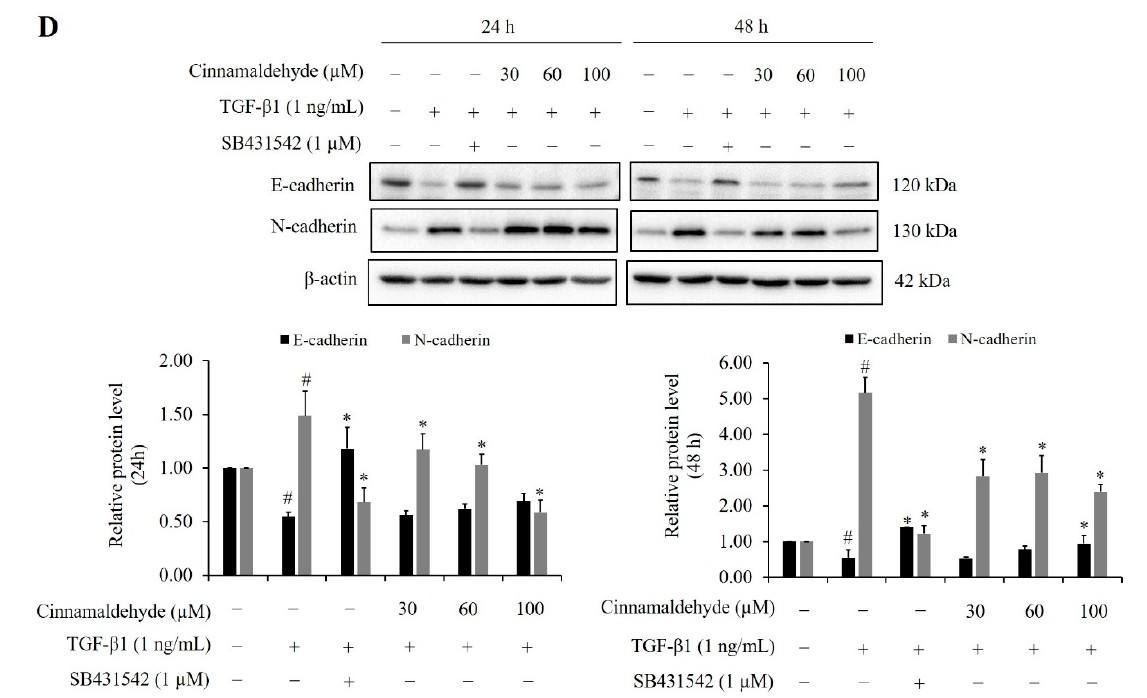
Figure 9. Effect of cinnamaldehyde on TGF- β 1- induced Smad2/3 phosphorylation and EMT markers in LoVo cells. ( A ) Cell viability was determined using MTT assay. ( B ) Cells were pre-treated with cinamaldehyde for 30 min, then cultured in TGF- β 1 for an additional 24 and 48 before detection of morphological changes. ( C ) The phosphorylation of Smad2/3 was determined by Western blot analysis. ( D ) Western blotting of the E-cadherin and N-cadherin EMT marker proteins. β -actin was used as an internal control. Data are mean values ± SD of three independent experiments ( n = 3). # p < 0.05 compared to the control group. * p < 0.05 compared to the TGF- β 1 treated group. CBE, Cinnamomum bejolghota extract; SD, standard deviation.